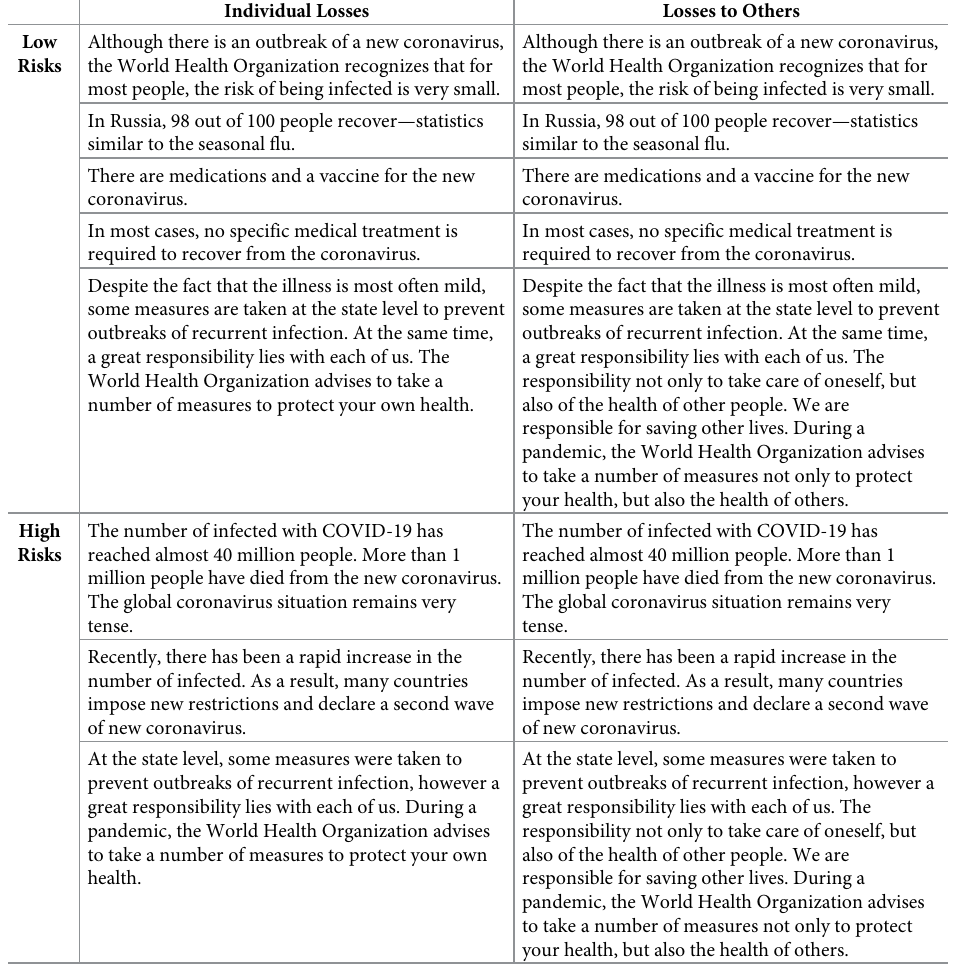
Table 5. Experimental vignettes used in Experiment